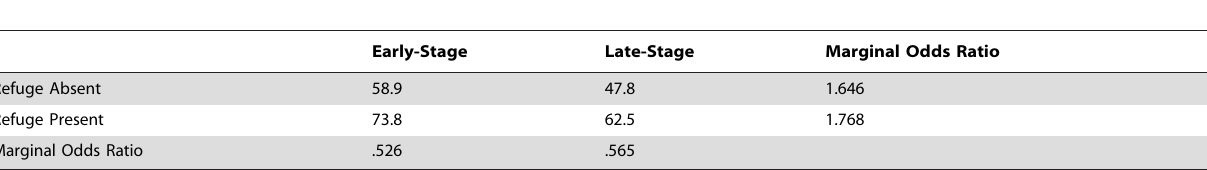
Table 2. Survival percentages and marginal odds ratios for female western mosquitofish at early and late stages of pregnancy and with and without a refuge